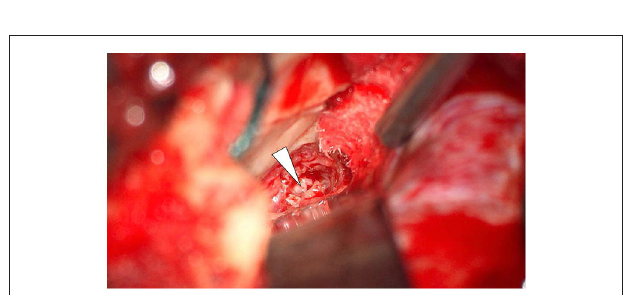
FIGURE 3 | Middle cranial fossa craniotomy demonstrating the lesion in the petrous apex (arrowhead).